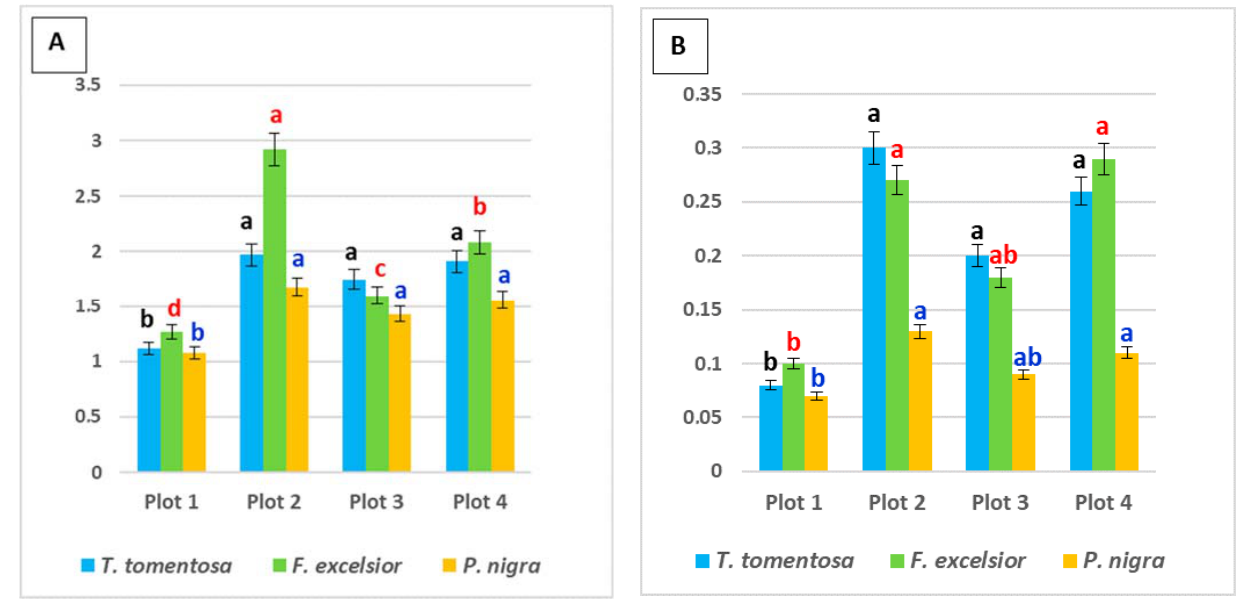
Figure 2. Content (mg g − 1 fresh weight) of photosynthetic pigments in the leaves of studied tree species, planted in four urban plots with different types and intensity of anthropogenic impact: ( A ) total chlorophyll content; ( B ) carotenoid content. For each tree species ( Tilia tomentosa in black, Fraxinus excelsior in red; Pinus nigra in blue), means showing different letters are significantly different according to Student’s LSD comparison test ( p < 0.05).